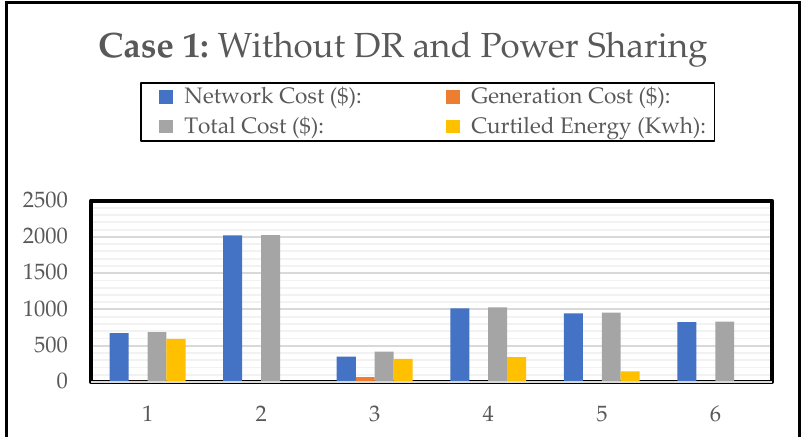
Figure 7. Cost and curtailed energy for Case 1.